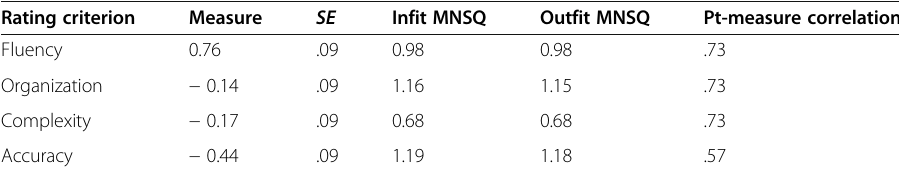
Table 4 Rasch statistics for human rating components Rating